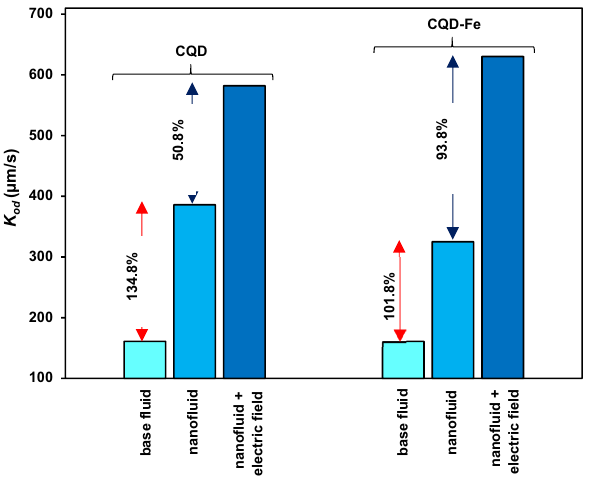
Figure 11. Comparison of mass transfer enhancements of nanofluid drops, with and without pulsed electric field for the largest nozzle No. 6; electric field strength of 16 V/cm and frequencies of 150 and 250 Hz for CQD and CQD-Fe nanofluids.